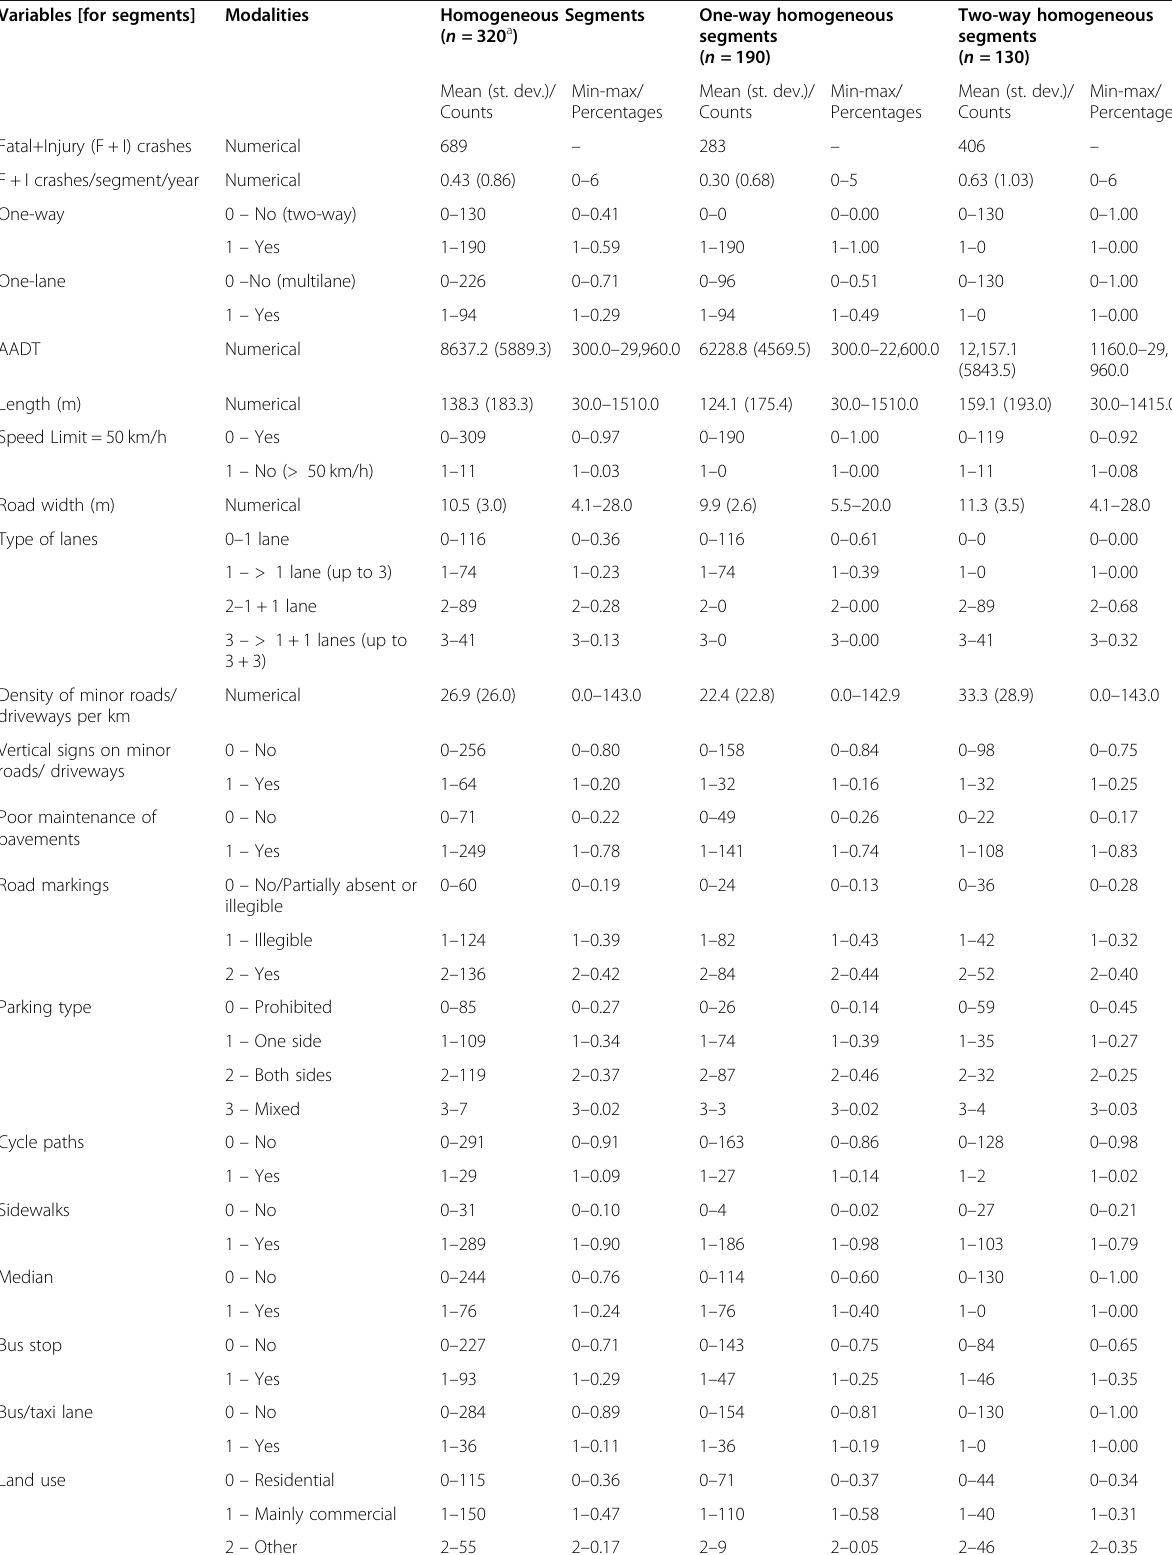
Table 1 Descriptive statistics of potential crash predictors for segments and